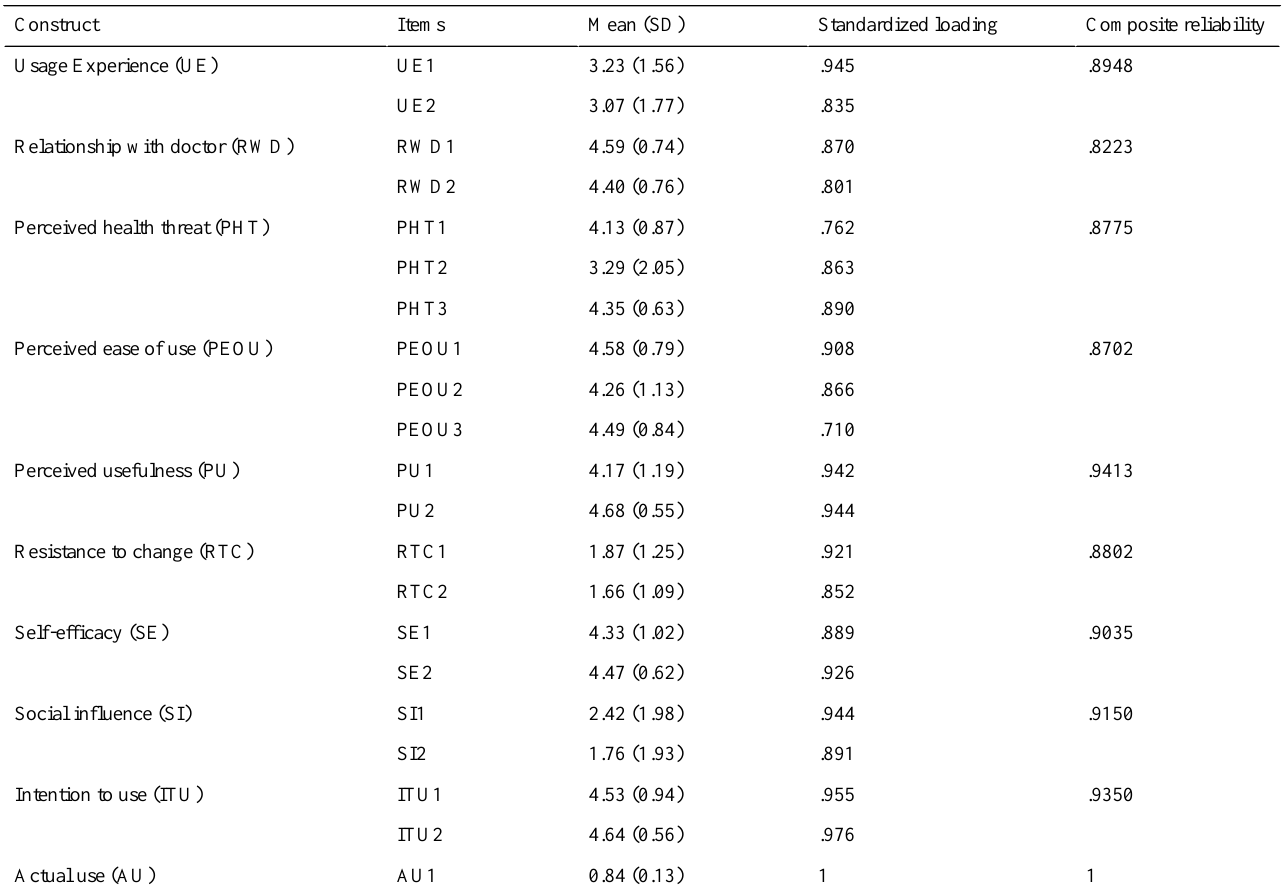
Table 3. Descriptive statistics of the variables and the reliability coefficients.